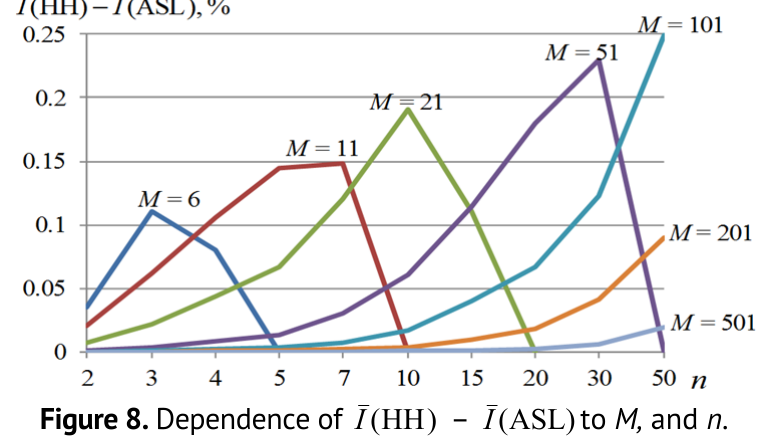
Figure 8. Dependence of